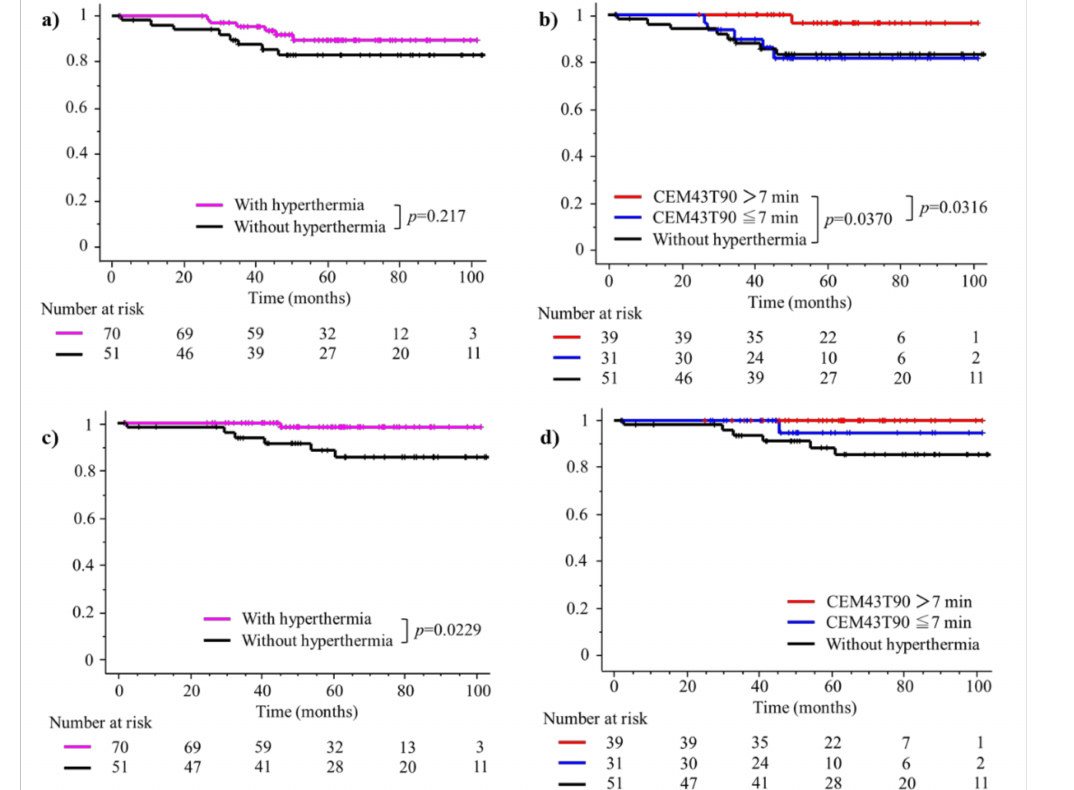
Figure 3. bDFS and clinical RFS rates. ( a ) bDFS with and without hyperthermia treatment. ( b ) bDFS among patients administered a thermal dose of CEM43T90 > 7 min, CEM43T90 ≤ 7 min, or no hyperthermia treatment. ( c ) Comparison of clinical RFS between the groups with and without hyperthermia treatment. ( d ) Comparison of clinical RFS among the patients with thermal dose CEM43T90 > 7 min, CEM43T90 ≤ 7 min, and no hyperthermia